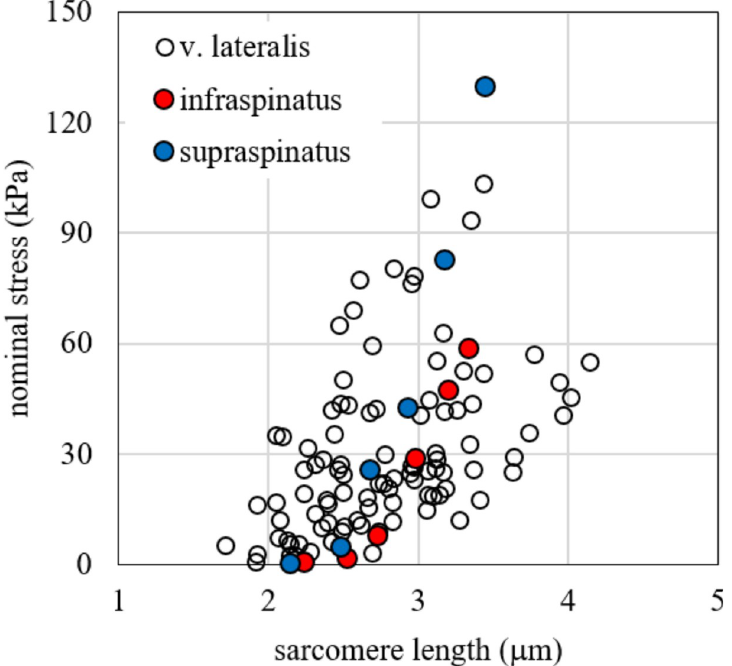
Fig 7. Stress vs. sarcomere length. Stress vs. sarcomere length experimental data for passive elongation of bundles tested in the present work compared with experimental data on infraspinatus and supraspinatus found by Silldorff et al.